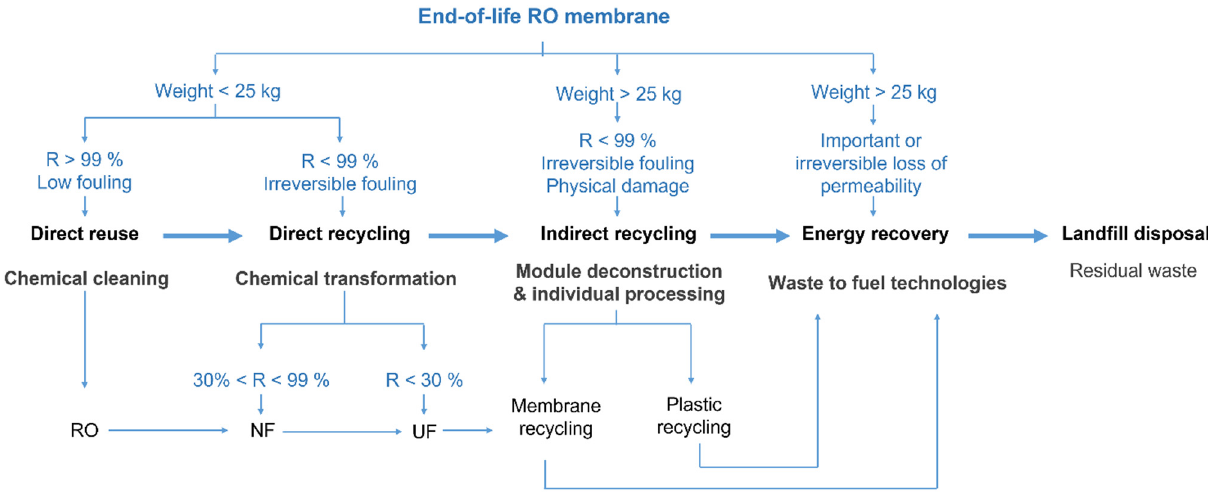
Figure 5. Cascade open loop reuse, recycling, and recovery alternatives for EoL RO membrane modules. R, Rejection coefficient; RO, reverse osmosis; NF, nanofiltration; UF, ultrafiltration.